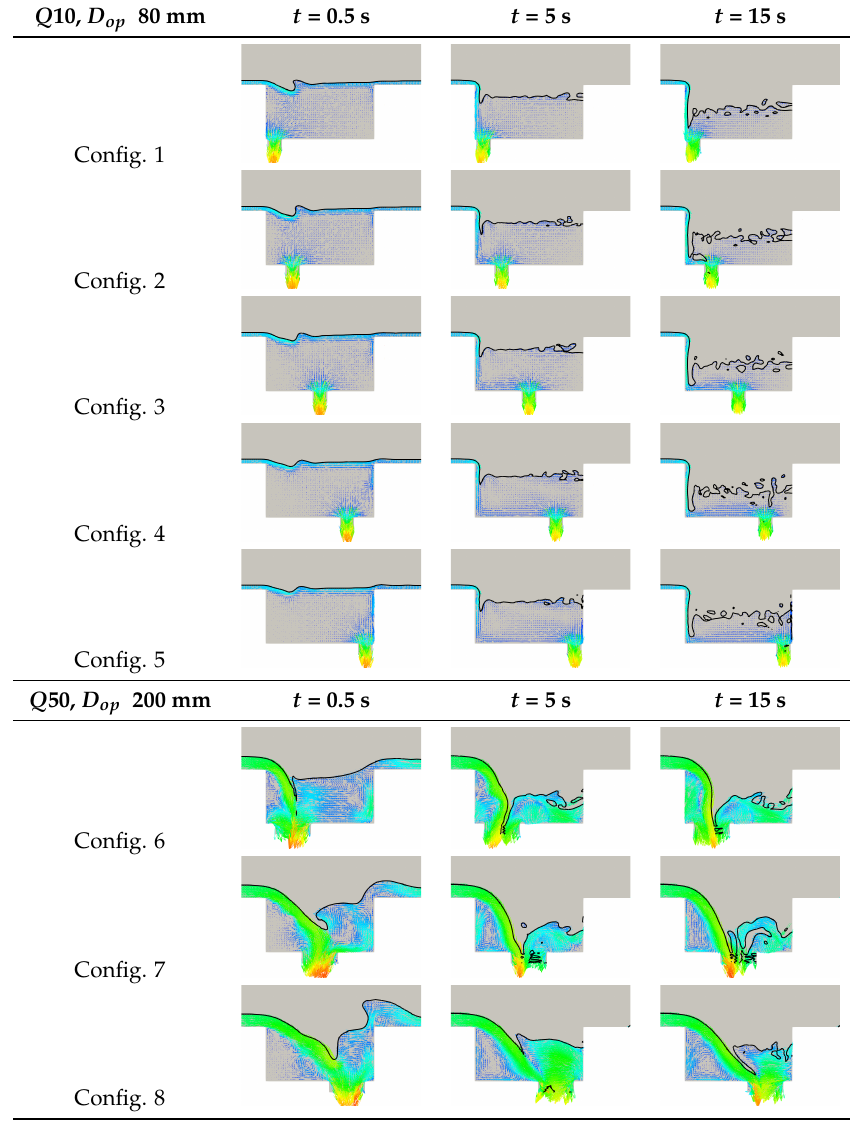
Table 3. Flow through the gully in its central plane—Config. 1 to 5 ( D op = 80 mm) for Q10 , Config. 6 to 8 ( D op = 200 mm) for